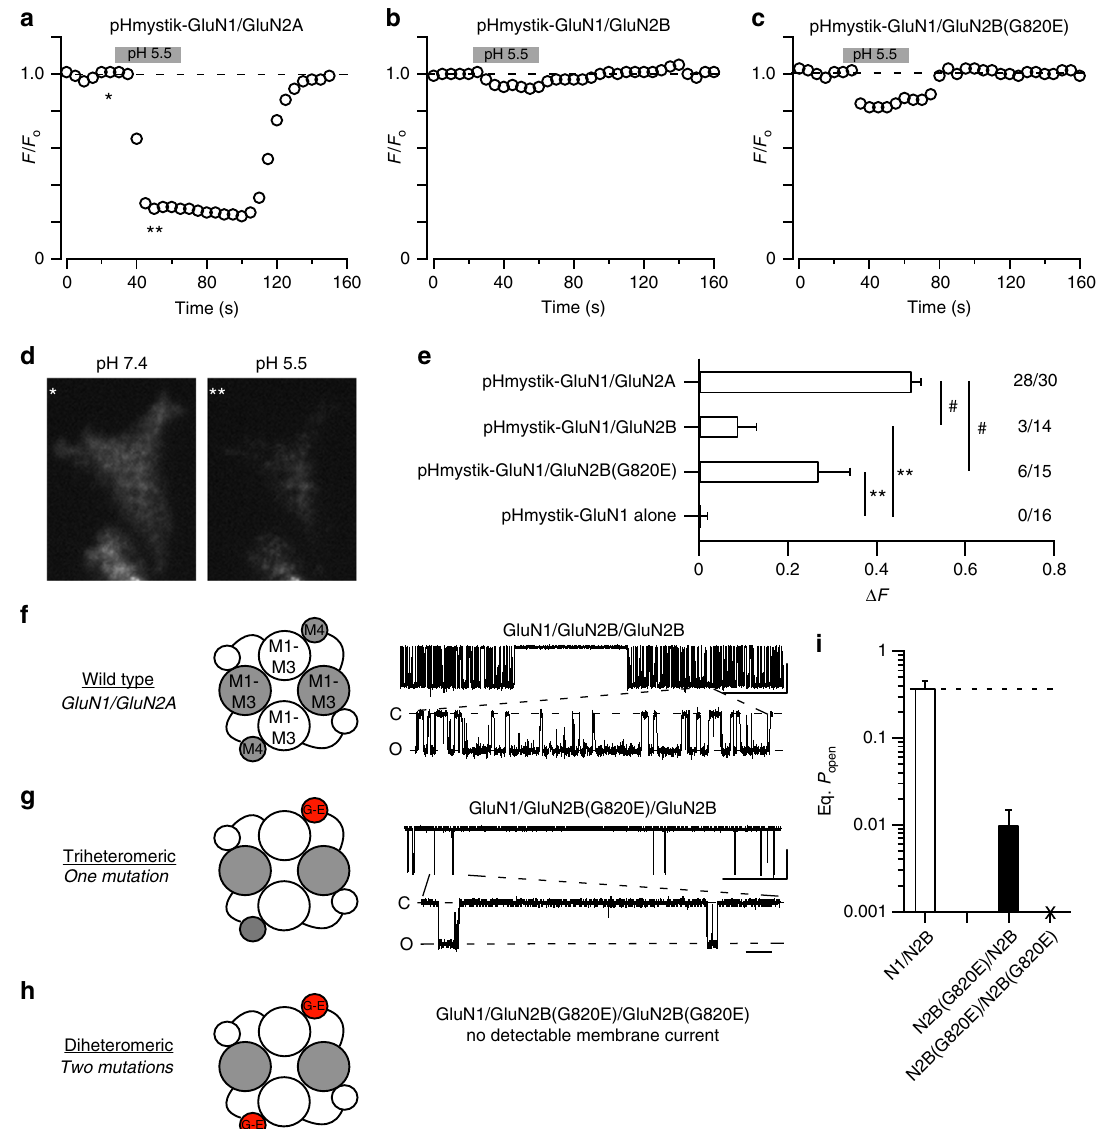
currents for GluN1(G827R) probably re fl ects that C-terminal positions in M4, especially this glycine, impact receptor surface expression 16 . A missense mutation at the conserved glycine is pore dead . The lack of glutamate-activated current for GluN2B(G820E), either